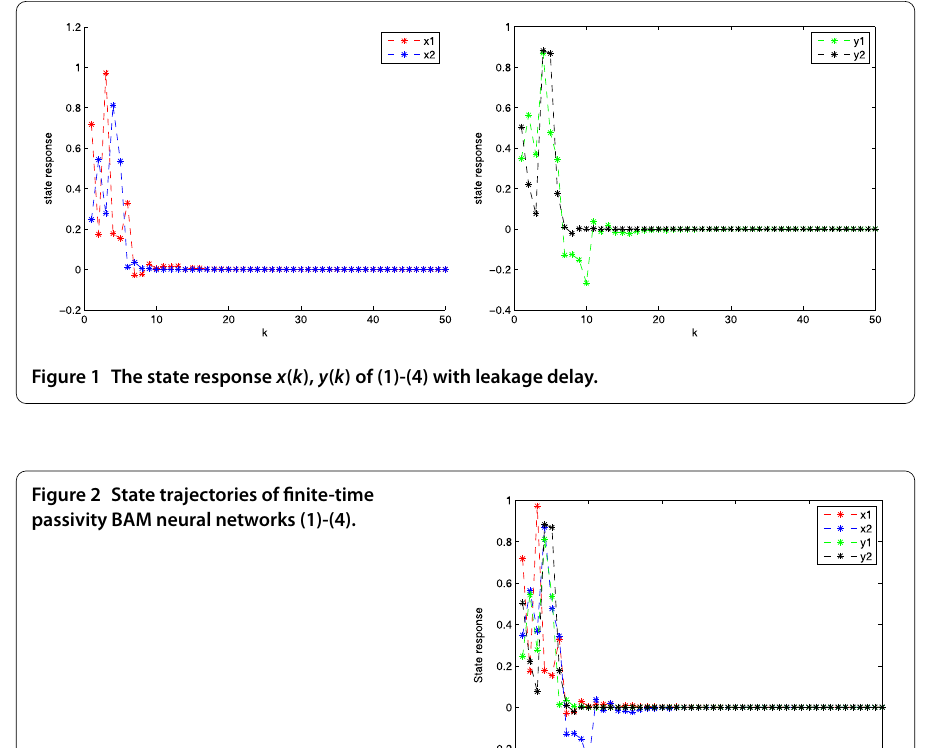
Figure 3 r ( k ) denotes Markovian jump of (1)-(4).